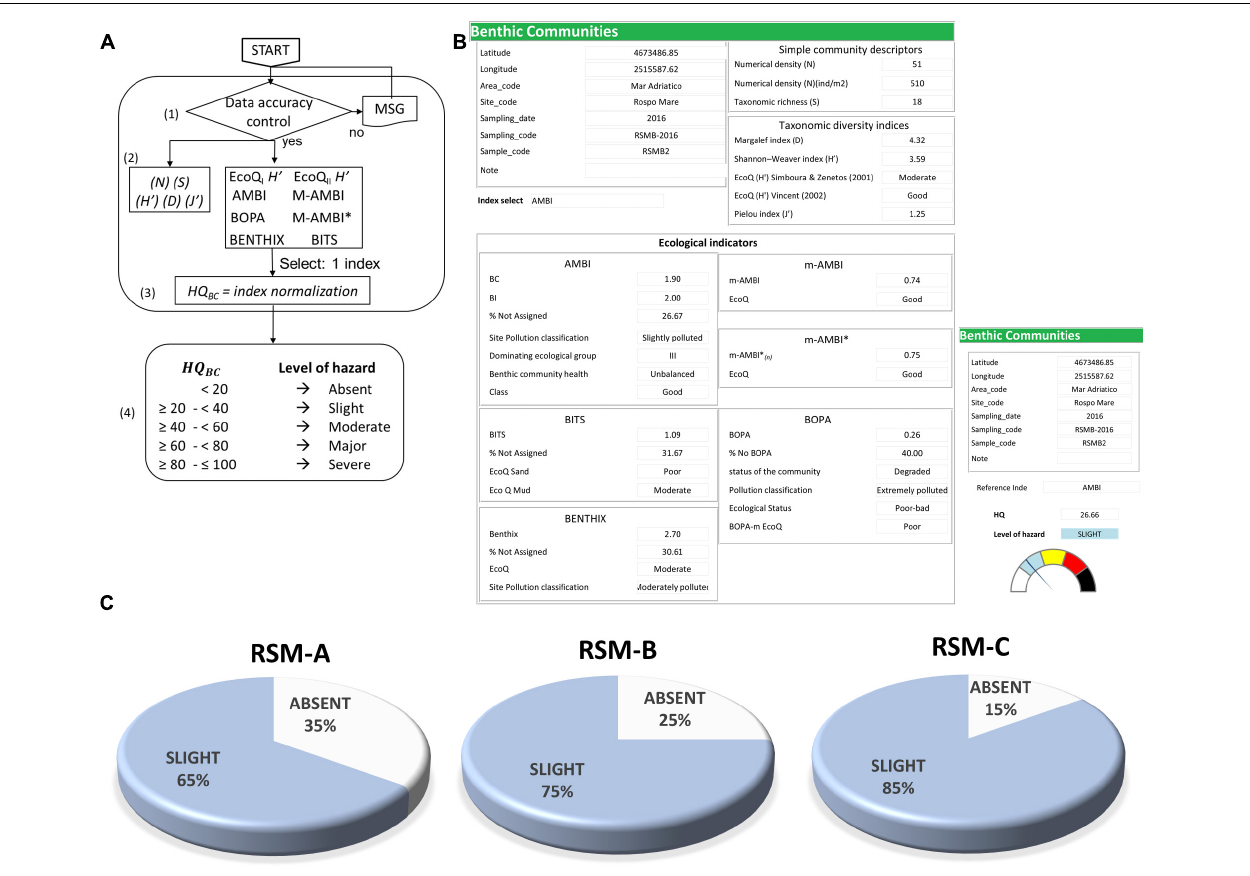
FIGURE 6 | LOE-5: elaboration of benthic communities analyses. (A) Flowchart for the calculation of different indices. (B) Model output for elaborations of benthic communities. (C) Results obtained for the three platforms indicating the percentage of samples assigned to various classes of